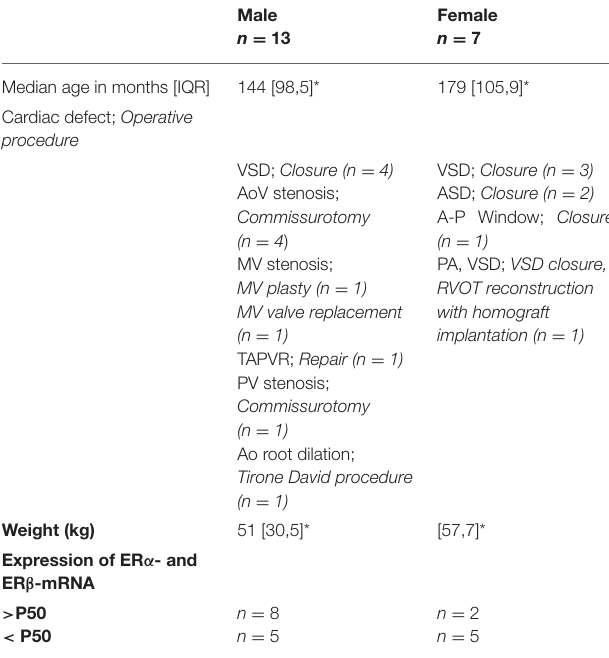
TABLE 1 | Patient